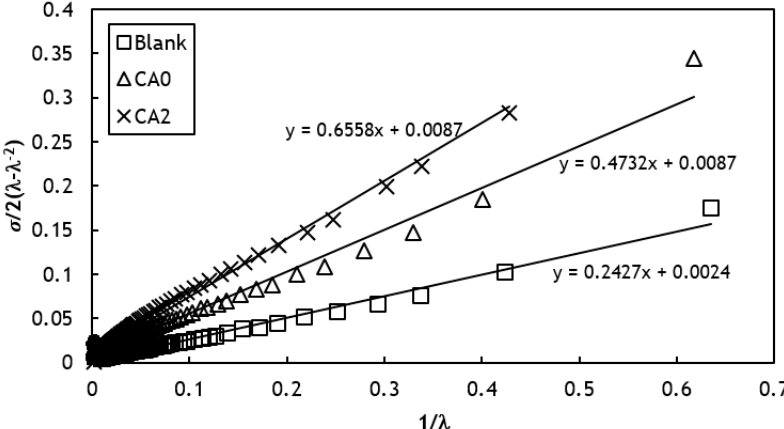
Figure 4. Linear regression of Mooney–Rivlin plots to obtain intercept (C1) as parameter for calculating crosslink density for Blank, CA0, and CA2.